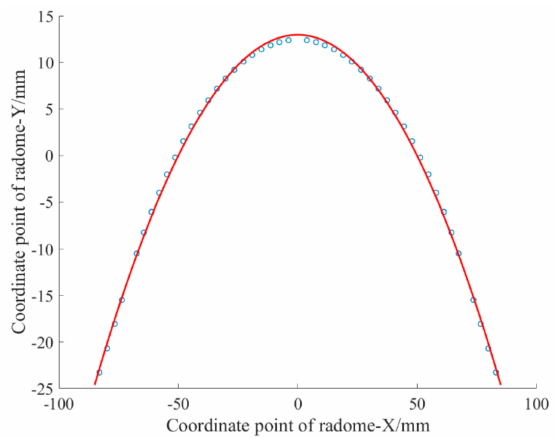
Figure 2. Least-squares optimization fit curve.